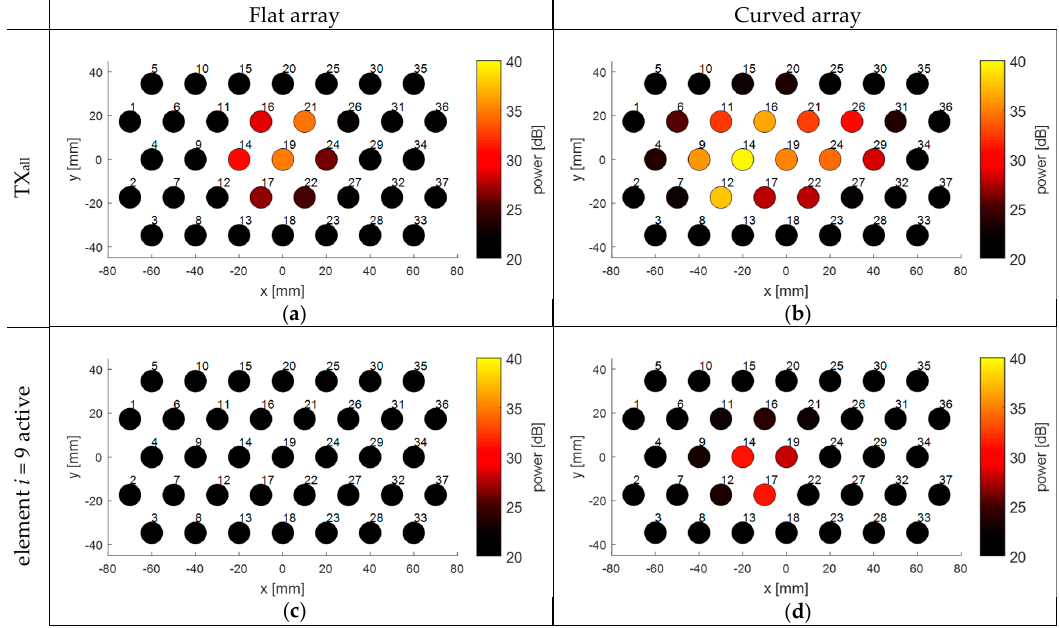
Figure 8. Effect of the curvature of the flexible transducer array on the received Doppler power in the individual elements. The number next to the transducer element indicates the element index i . The measurements were performed using an in-vitro beating heart setup. The heart was centered in front of the center of the array. ( a ) Received Doppler power when transmitting with all elements using a flat array; ( b ) Received Doppler power when transmitting with all elements using a curved array; ( c ) Received Doppler power when transmitting with element i = 9 only, using a flat array; ( d ) Received Doppler power when transmitting with element i = 9 only, using a curved array.